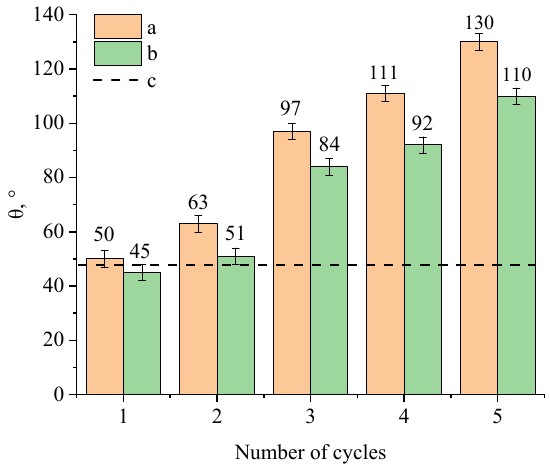
Figure 19. Dependence of the wetting contact angle on the number of application cycles: (a) ABE wires treated by sequential immersion in tetraethoxysilane and ammonia; (b) ABE wires treated by immersion in SiO 2 nanoparticles sol; (c) uncoated wires (control sample).